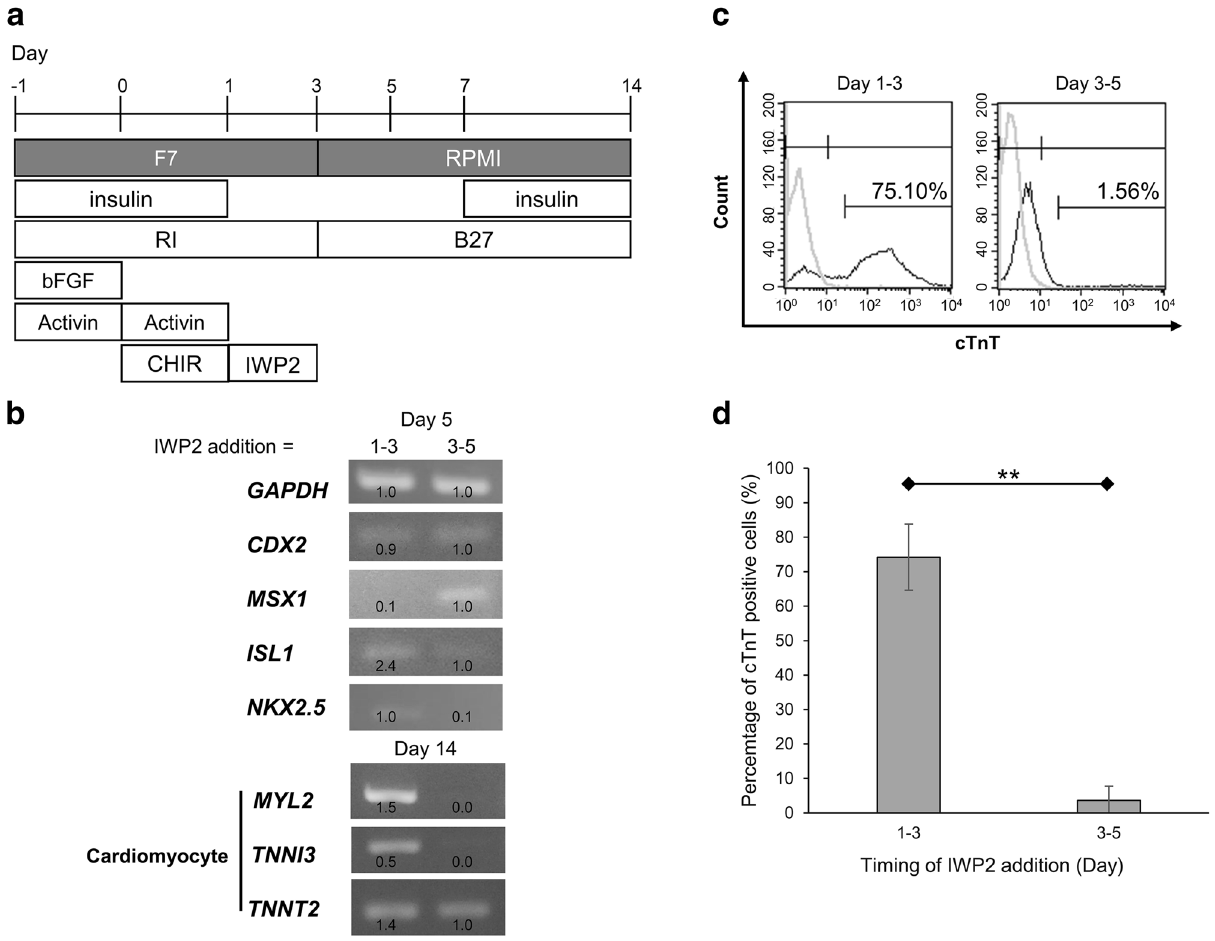
Figure 4. Early addition of Wnt inhibitor during days 1–3 was sufficient to improve cardiomyocyte differentiation efficiency at a low initial cell density. ( a ) Schematic of the new protocol of cardiomyocyte differentiation at an initial low cell density, with early addition of IWP2 from day 1–3. ( b ) Expression of anti-cardiac mesoderm genes CDX2 and MSX1 and cardiac progenitor genes ISL1 and NKX2.5 on day 5. The expression levels of cardiomyocyte genes ( MYL2 , TNNI3 , and TNNT2 ) on day 14. IWP2 was added during days 1–3 or days 3–5. ( c ) Flow cytometry of cTnT-positive cells induced by IWP2 treatment during days 1–3 and days 3–5. ( d ) The percentage of cTnT-positive cells under the same conditions as in ( c ). Mean ± SE, ** P < 0.01, t-tests with Dunnett’s correction, n =